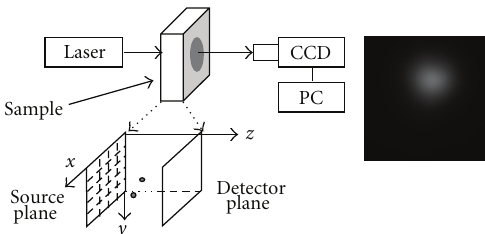
Figure 6: A schematic diagram of the experimental arrangement used for imaging objects embedded in a turbid medium. The inset at the bottom shows the 2D array in the input plane that was scanned across the incident laser beam; the inset to the right shows a typical raw image recorded by the CCD. (CCD: charge coupled device, and PC: personal